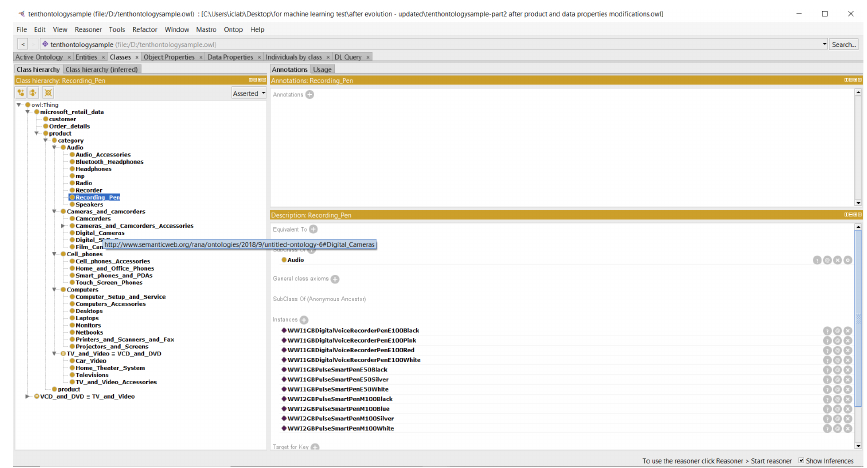
Figure 5. Online retail ontology individuals.